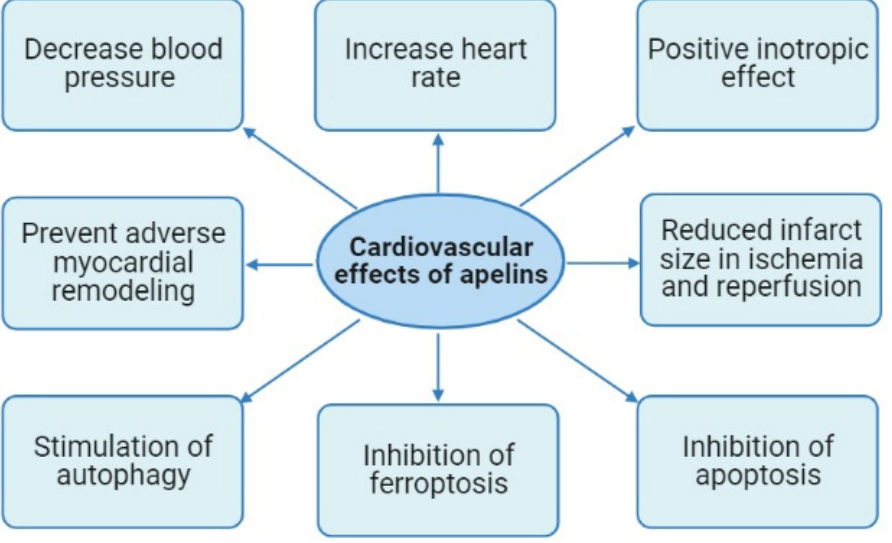
Figure 2. Cardiovascular effects of apelins.